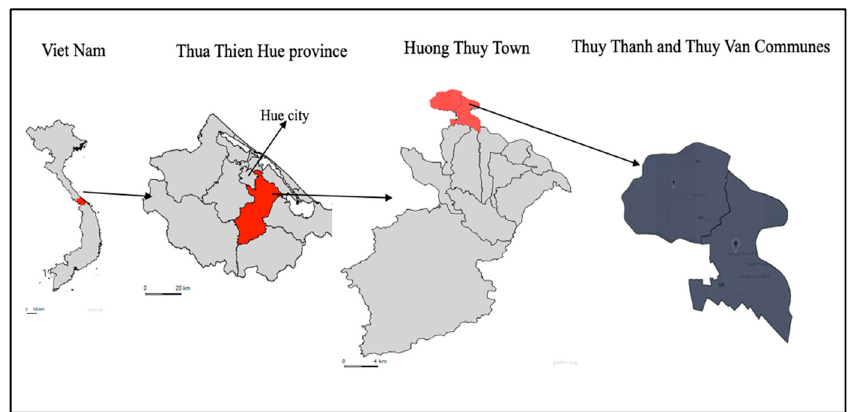
Figure 2. Mapping of study sites. (Source: Global Administrative Areas (GADM), 2018).